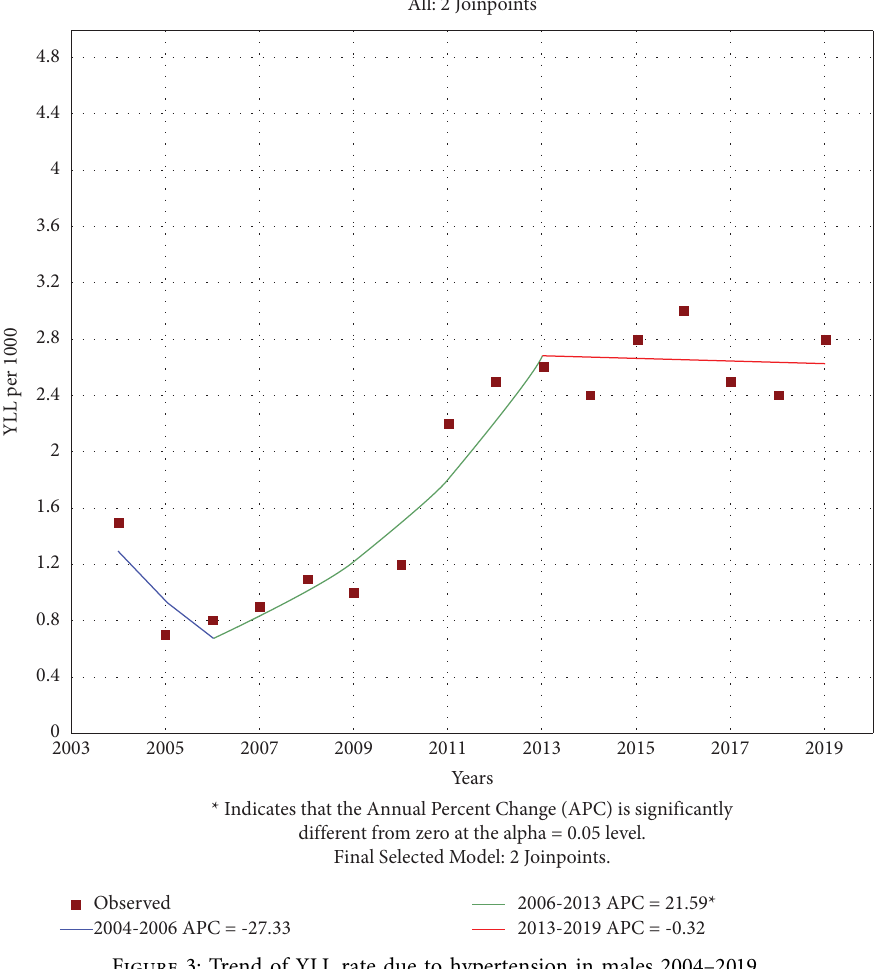
Figure 3: Trend of YLL rate due to hypertension in males